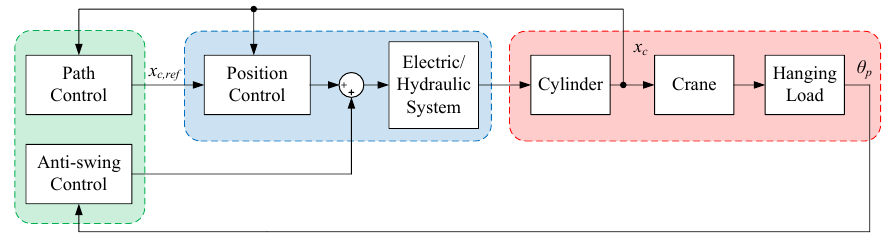
Figure 27. Block diagram of the path control, anti-swing control, and crane.